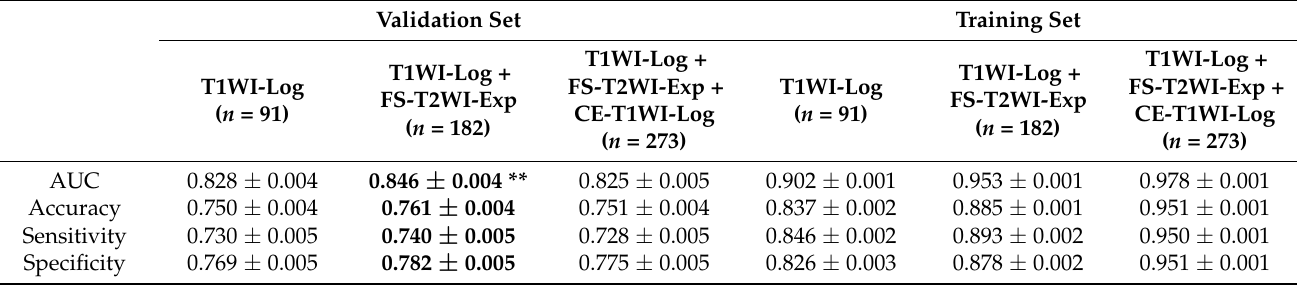
Table 4. Assessing the performances of the combined MRI sequence based on the best feature category to discriminate MSGTs from